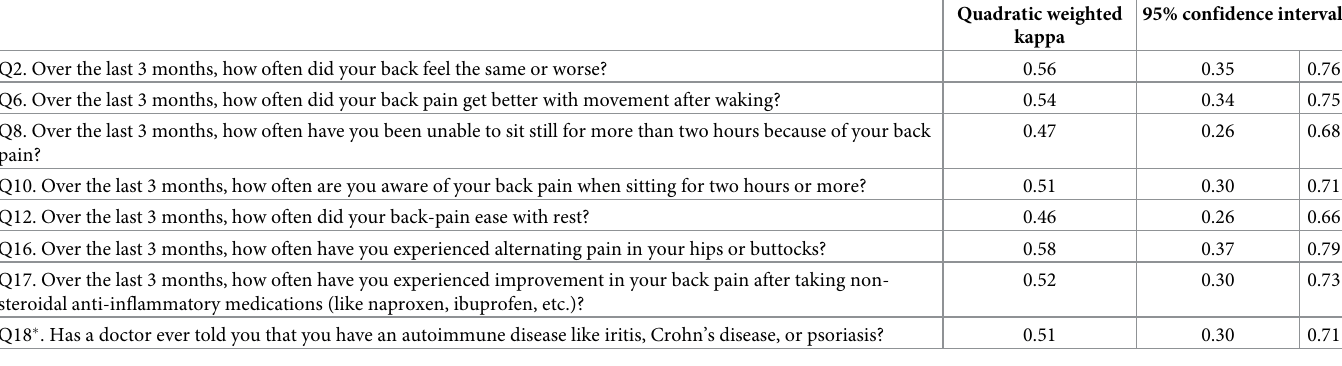
Table 4. List of questions excluded (kappa <